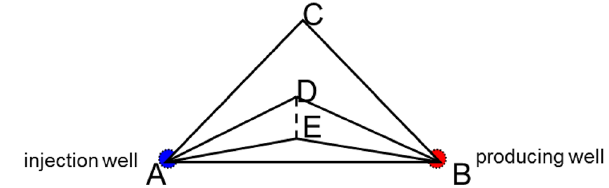
Fig. 3 The illustration of CU